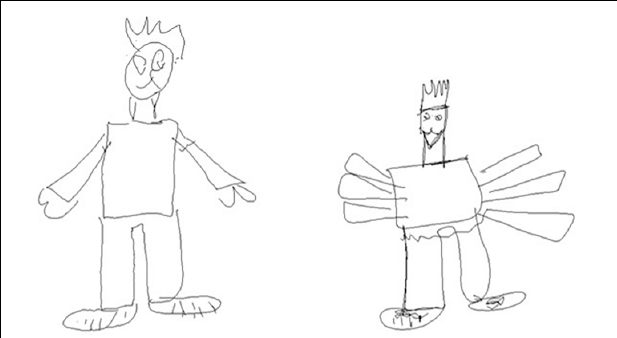
FIGURE 1 | Example of addition and deletion of elements in stylus drawing on tablet at 6th grade: compared to the unoriginal drawing (on the left), arms have been replicated and hands have been deleted in the original drawing (on the right).